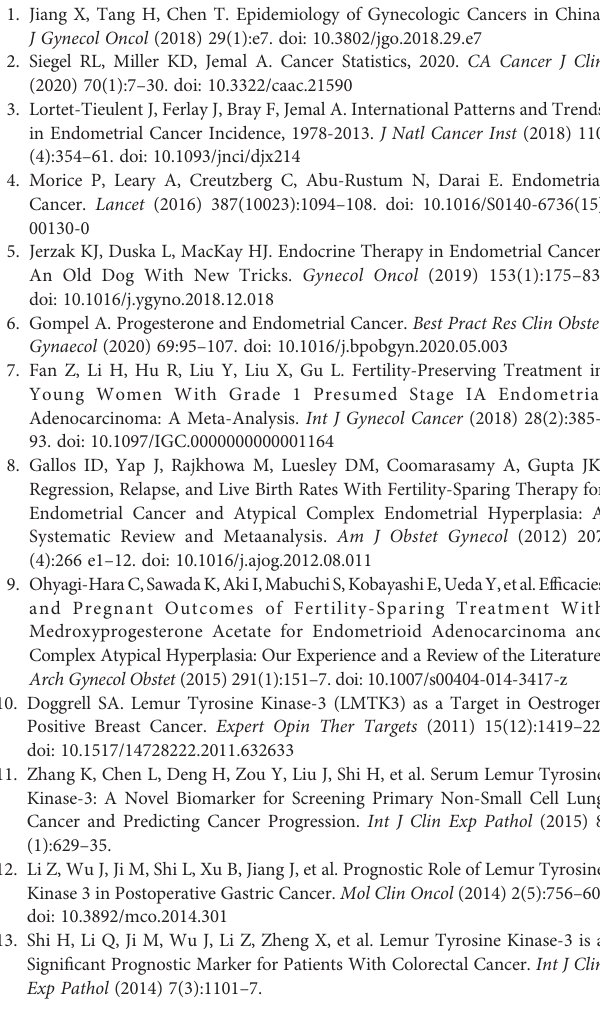
Supplementary Figure 1 | Statistical histogram of LMTK3 knockdown on early and late apoptosis in Ishikawa. (A) Statistical histogram of LMTK3 knockdown on early apoptosis in Ishikawa (n=3, * P < 0.05). (B) Statistical histogram of LMTK3 knockdown on late apoptosis in Ishikawa (n=3, * P <